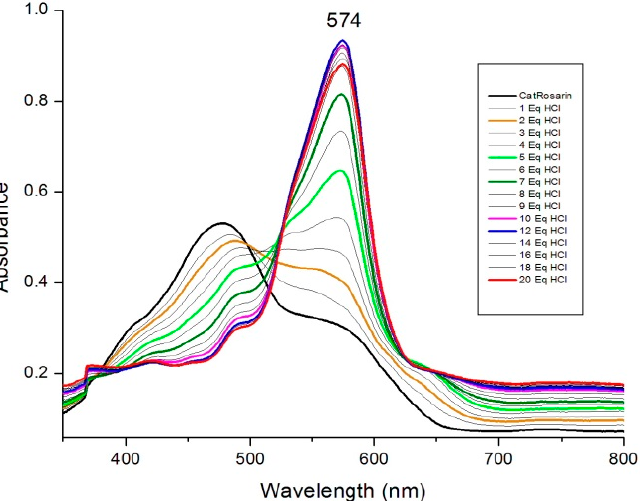
Figure 3. UV-vis absorption spectral change of rosarrin 3 [7.36 × 10 − 6 M] upon addition of HCl in CH 2 Cl 2 .